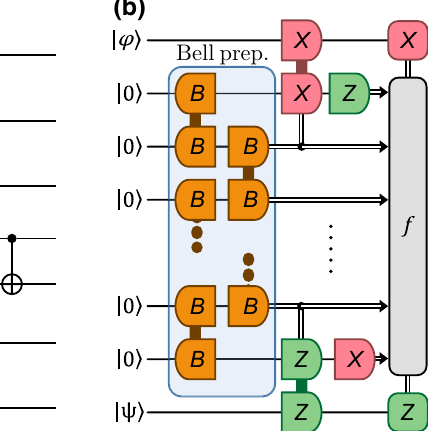
FIG. 2. Application of a CNOT ( q 0 , q 1 ) gate on qubits at distance k + 1 using sur- face code operations in two ways. (a) Using a SWAP -based approach requires (cid:2)( n ) depth using operations from Fig. 1, while (b) gen- erating and consuming a Bell pair [12] can be implemented in constant depth. The clas- sical function f computes Pauli corrections on the output